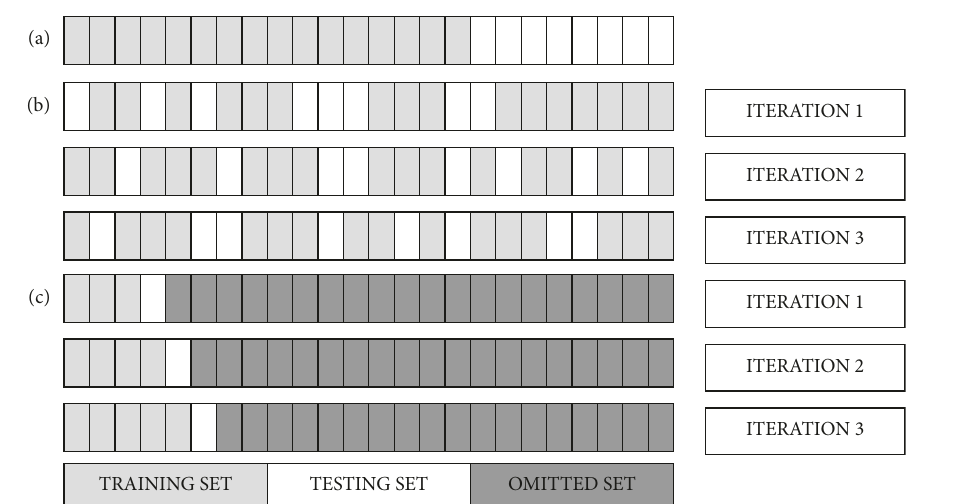
Figure 1: Schematic diagrams for (a) hold-out, (b) repeated hold-out, and (c) LOOCV resampling